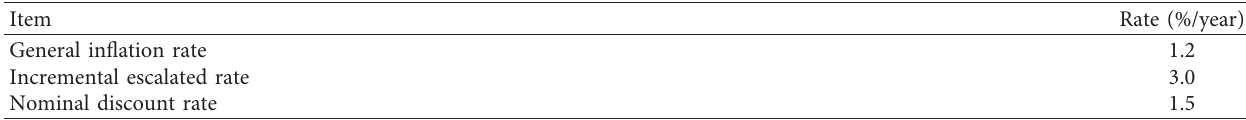
Table 8: Environmental economic parameters of 2020 [66–68].